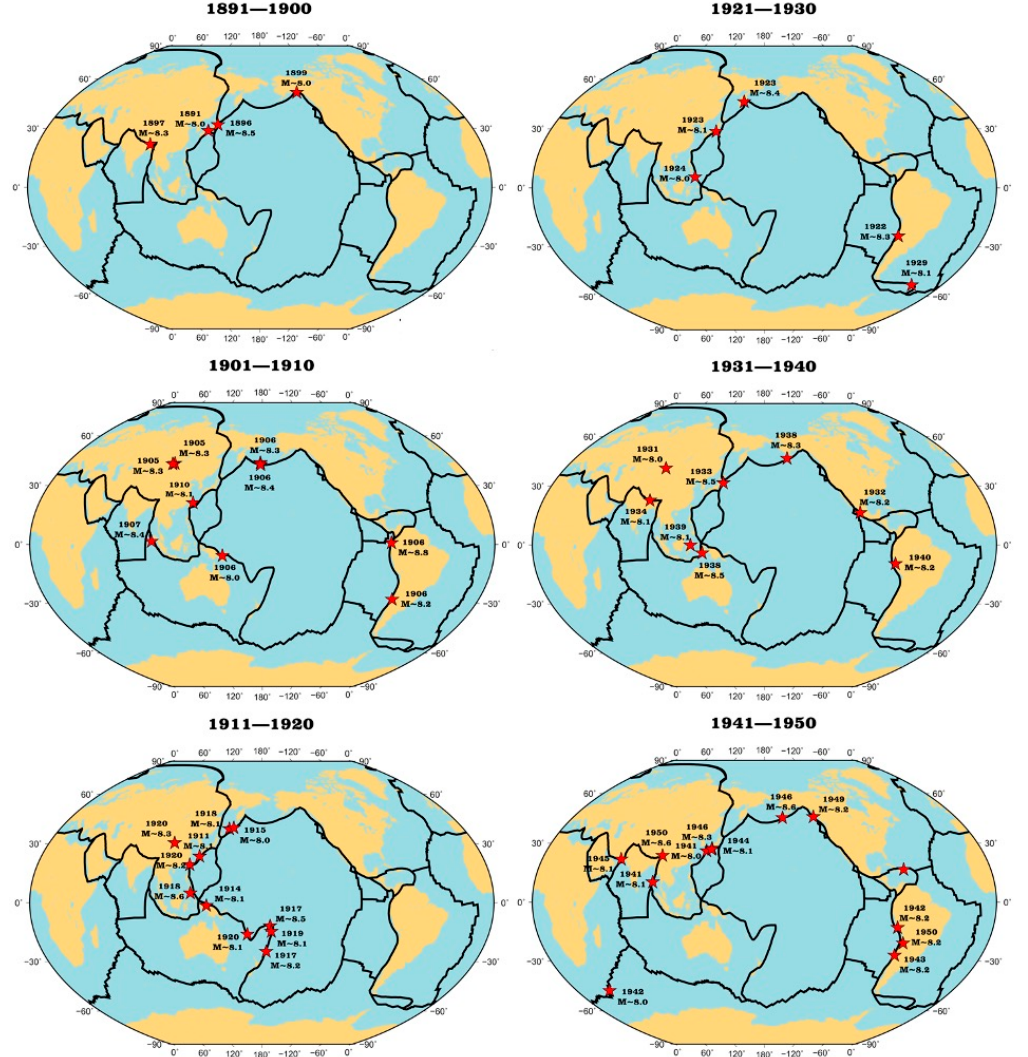
Figure 2. Global distribution of epicenters of the great earthquakes in 1891–1950. Plate boundaries according to NUVEL-1 model are shown as black lines; red stars indicate epicenters of earthquakes having magnitudes greater or equal to 8.0.